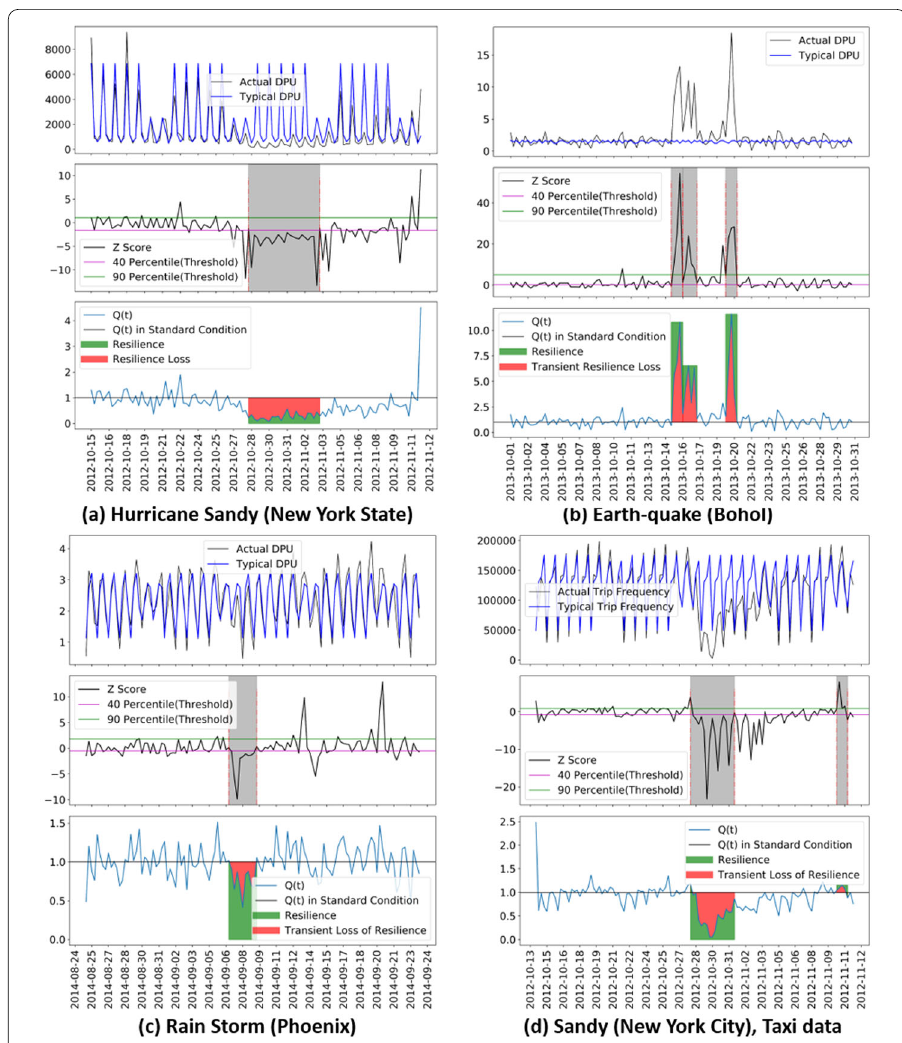
Figure 2 Resilience and transient loss of resilience for multiple disasters. Each figure has three panels; the first panel shows the actual and typical values; the second panel shows the event detection by z score; and the third panel shows the resilience and transient loss of resilience. Note: DPU = Displacements Per User (Kilometer), TF = Trip